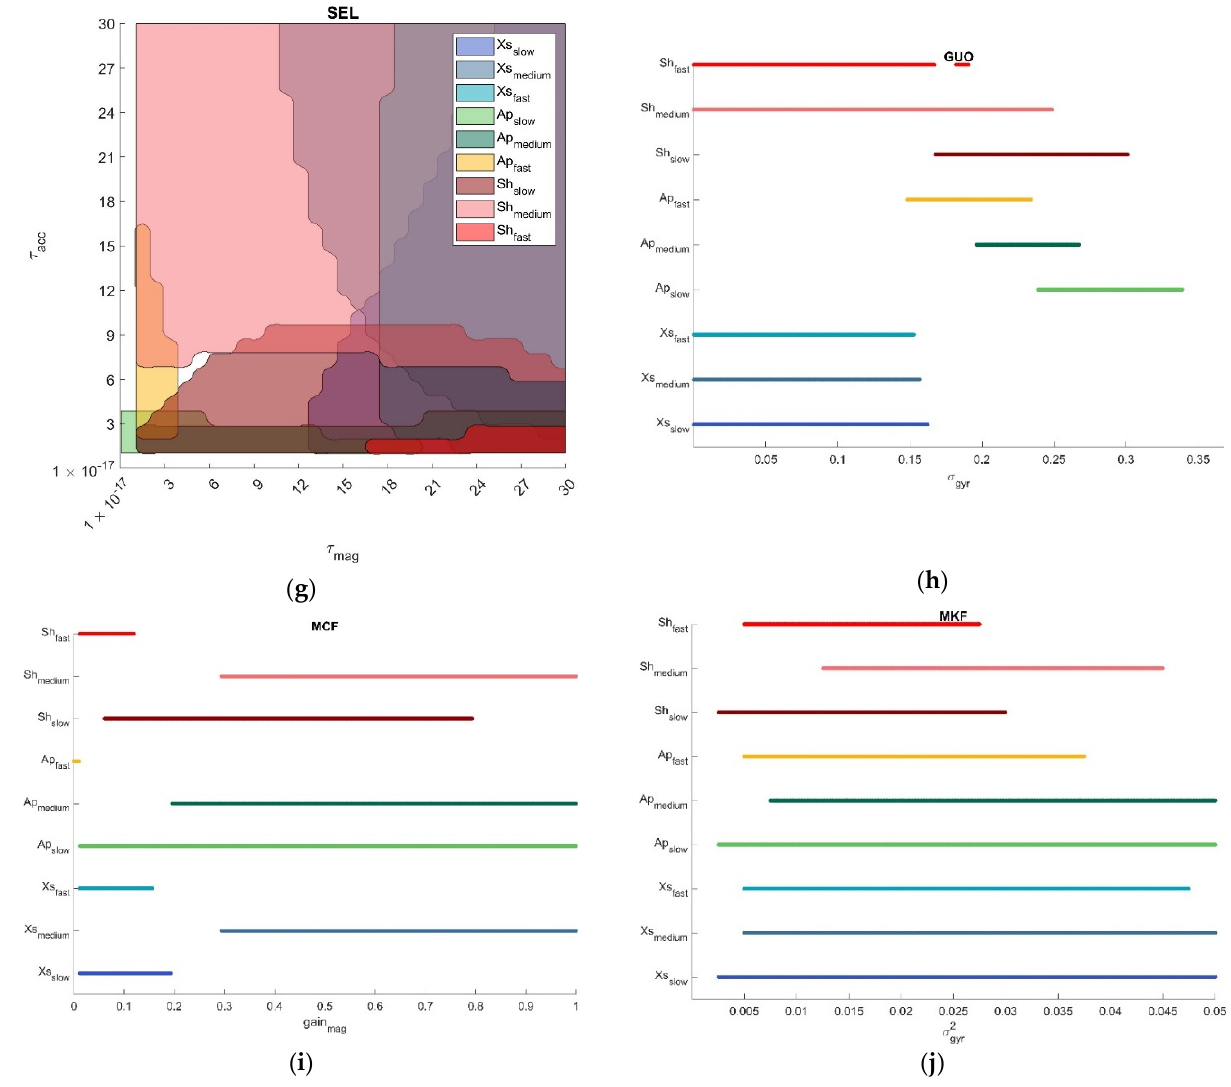
Figure A1. Optimal regions for each SFA and for each experimental condition. ( a ) MAH, ( b ) SAB, ( c ) MAD, ( d ) LIG, ( e ) VAC, ( f ) VAK, g ) SEL, ( h ) GUO, ( i ) MCF, ( j ) MKF.